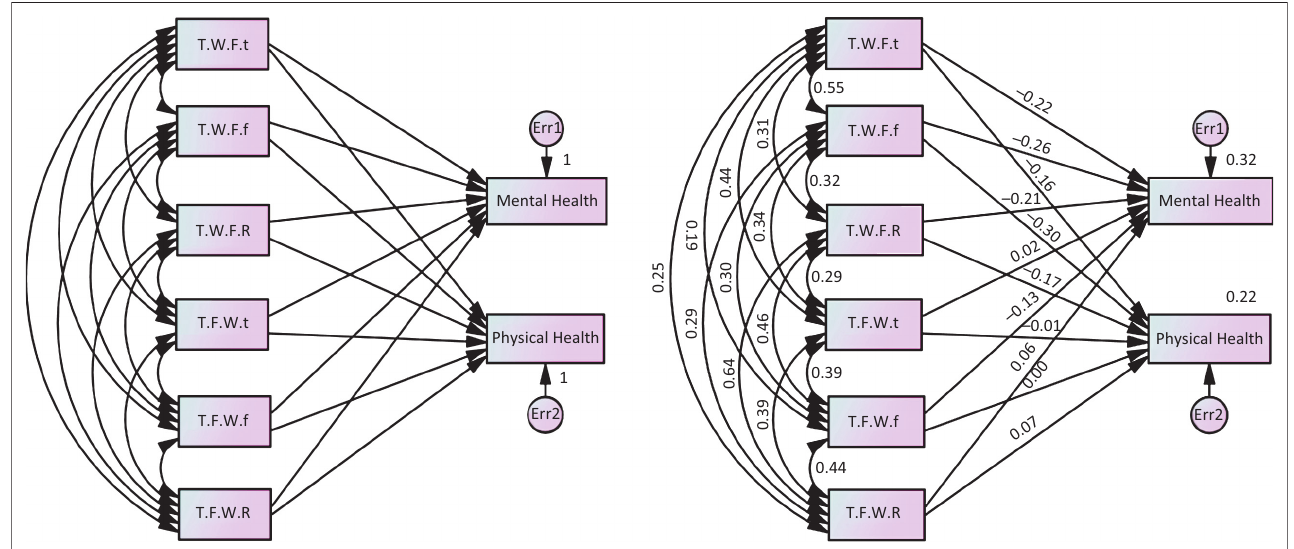
FIGURE 2: Proposed model of the relationship between the research